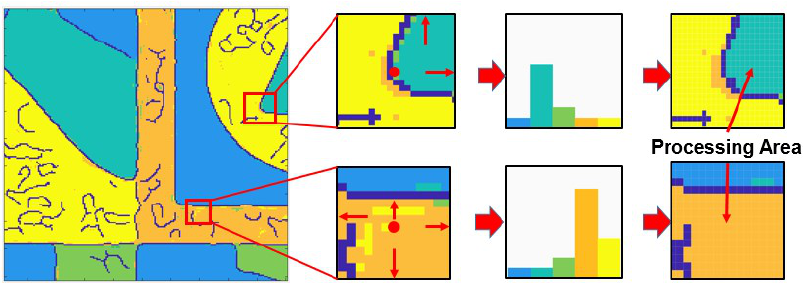
Figure 6. Class label correction